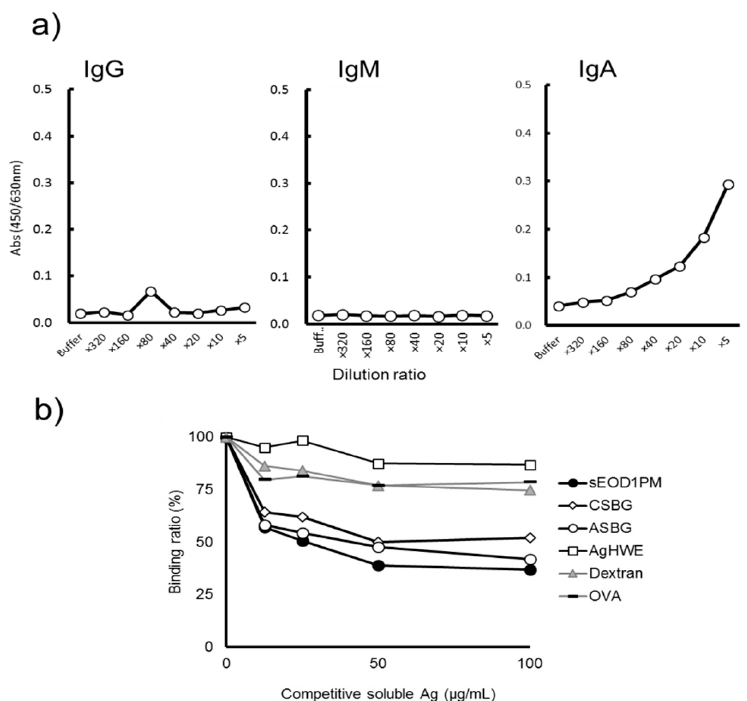
Figure 5. Reactivity of antibody against Euglena gracilis EOD-1 paramylon (EOD1PM) in human saliva. ( a ) Reactivity of human salivary anti-sEOD1PM IgG, IgM, and IgA antibody. An ELISA plate was coated with sEOD1PM and blocked. Saliva samples were diluted, and the amount of plate-bound Ig was determined using the detection antibody. ( b ) Specificity of the human salivary anti-sEOD1PM IgA antibody. An ELISA plate was coated with sEOD1PM and blocked. Human saliva was mixed with serially diluted competitive soluble antigen and then applied to the ELISA plate. The amount of plate-bound Ig was determined using the detection antibody.